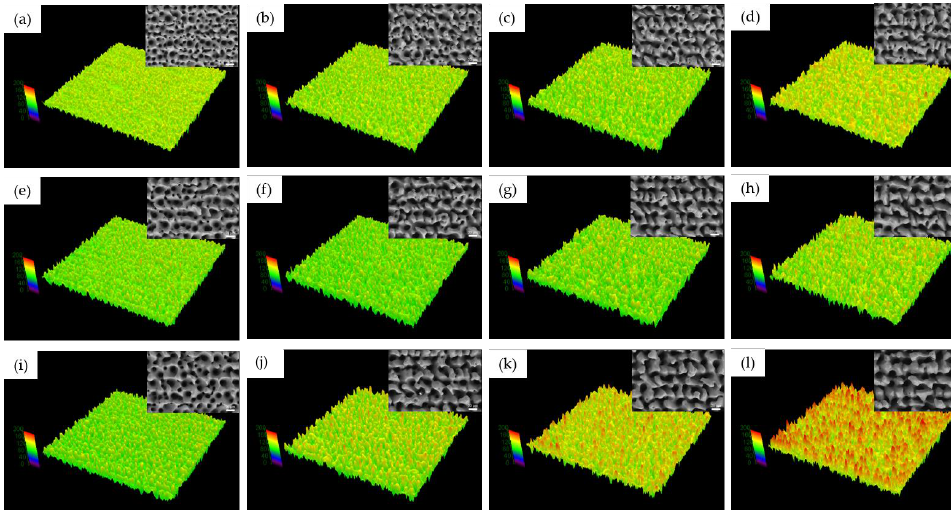
Figure 4. Femtosecond laser-induced surface micro-structure morphology by LSCM and SEM: ( a ) 80 µ J, 40 scans, ( b ) 80 µ J, 80 scans, ( c ) 80 µ J, 160 scans, ( d ) 80 µ J, 320 scans, ( e ) 100 µ J, 40 scans, ( f ) 100 µ J, 80 scans, ( g ) 100 µ J, 160 scans, ( h ) 100 µ J, 320 scans, ( i ) 120 µ J, 40 scans, ( j ) 120 µ J, 80 scans, ( k ) 120 µ J, 160 scans, ( l ) 120 µ J, 320